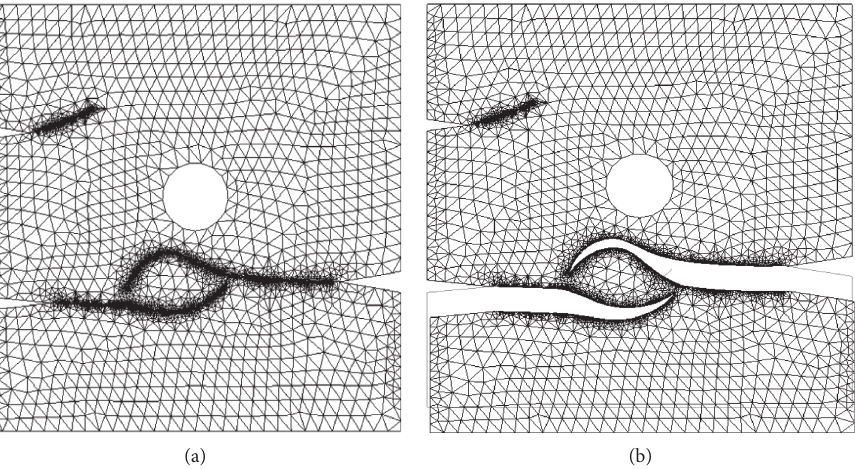
Figure 6: Final crack growth path and the deformed mesh.